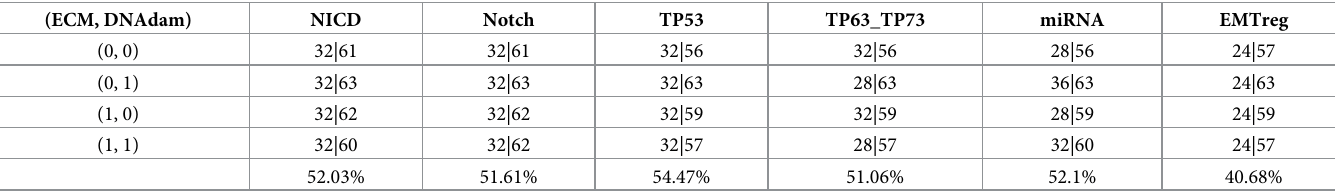
list the full list of transitions to be removed from EMT-BW to capture the original EMT model, and depict the resulting network graph separated by the corresponding parameter set.